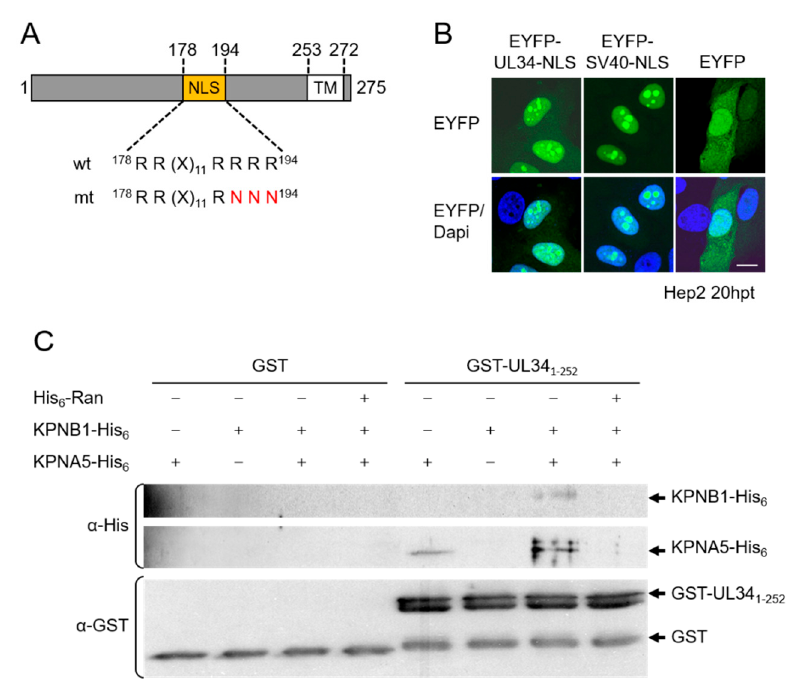
Figure 2. The NEC protein pUL34 contains a functional bipartite NLS. ( A ) Schematic depiction of the TA membrane protein pUL34 with the bioinformatically predicted bipartite NLS (residues 178–194) and the exchanged residues in case of the NLS mutation (red). ( B ) To determine whether the UL34-NLS can mediate the nuclear import of a cytoplasmic protein, Hep2 cells were transfected with plasmids encoding EYFP-UL34-NLS and EYFP-SV40-NLS as the positive control and EYFP alone as the negative control. Then, 20 h post transfection (hpt), EYFP was visualized directly and nuclei were detected by Dapi. Scale bar corresponds to 10 µm. ( C ) Formation of a nuclear import complex in vitro was started with binding of GST-pUL34 1-252 or GST alone as the negative control to GSH sepharose followed by incubation with KPNB1-His 6 , KPNA5-His 6 and His 6 -RanGTP, either alone or in combinations. Eluates were analyzed by SDS-PAGE followed by Western blotting using mouse anti-His or goat anti-GST antibodies, followed by POX-conjugated secondary reagents.